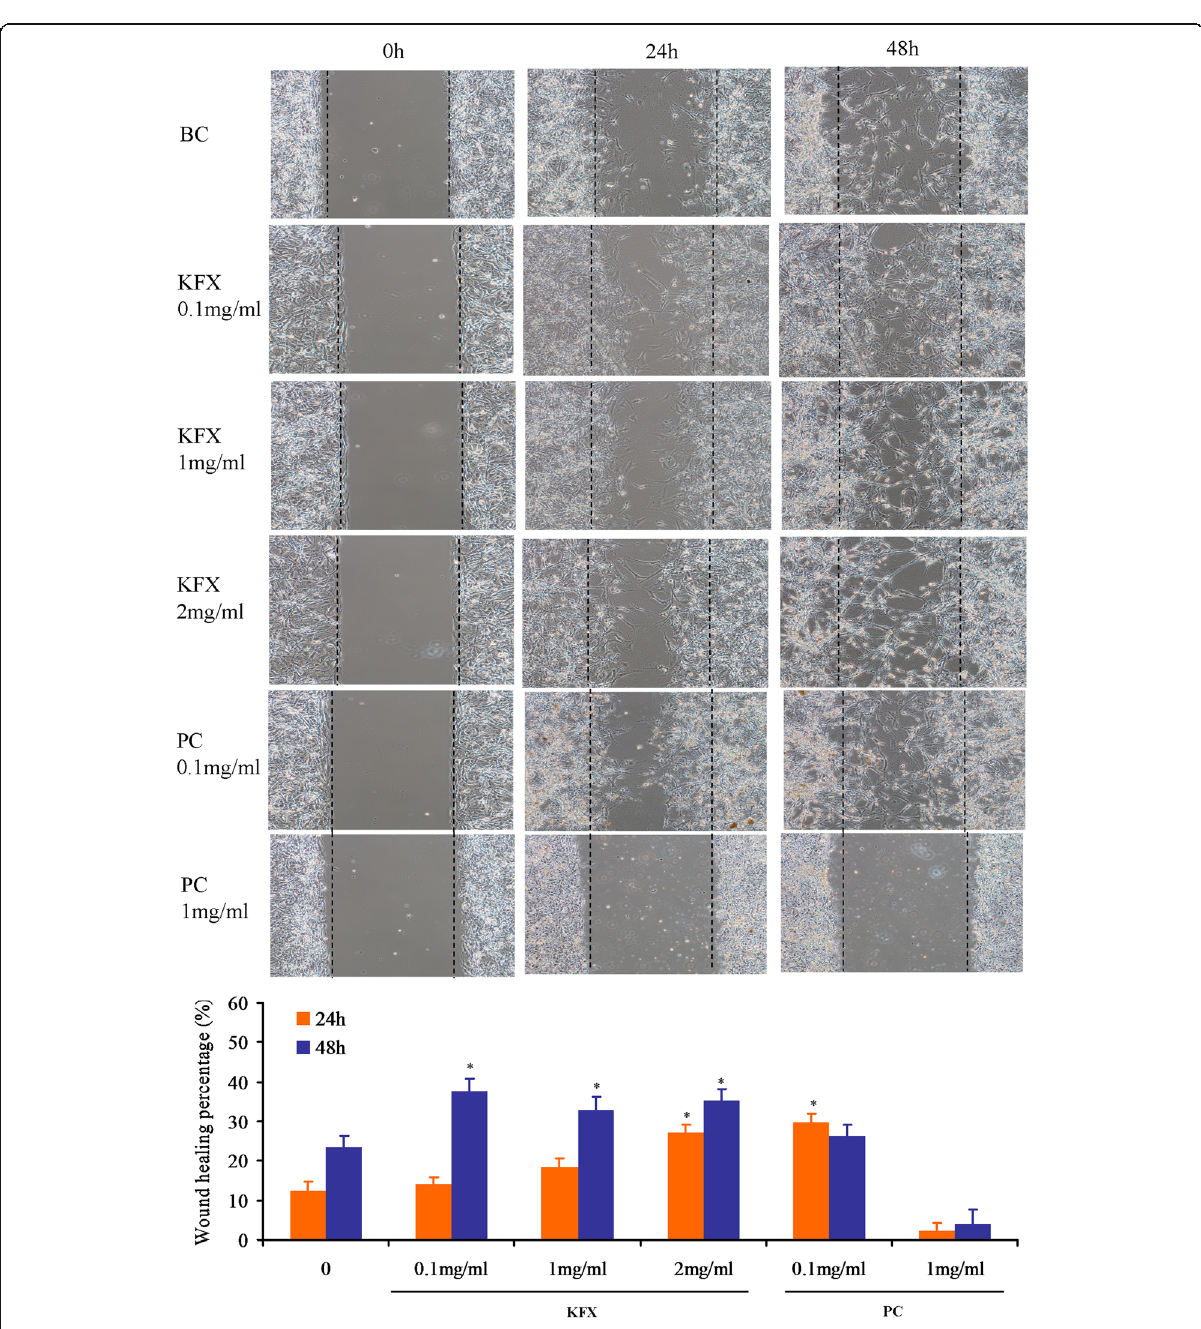
Fig. 1 Osteoblasts migration assay. The migration of osteoblasts was measured with wound scratch assay. Osteoblasts were treated with KFX (0.1, 1 and 2 mg/mL), or PC substance (0.1 and 1 mg/mL). Significant migration was observed in cells treated with KFX (0.1, 1 and 2 mg/mL) compared with the blank control group. The quantitative evaluation and statistical analysis of wound closure percentage in wound scratch assay measured by Image J software. Results are expressed as means ± SD of three experiments (* P < 0.05, versus blank